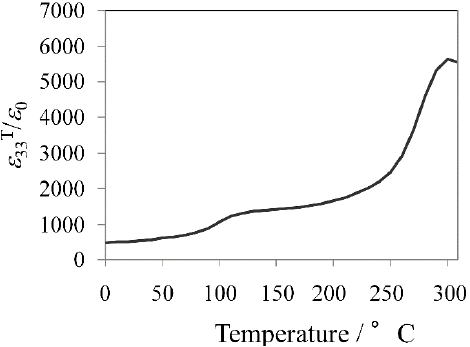
Figure 8. Temperature dependence of dielectric permittivity for KNN ‐ CZ ‐ 3 single ‐ layer sample.